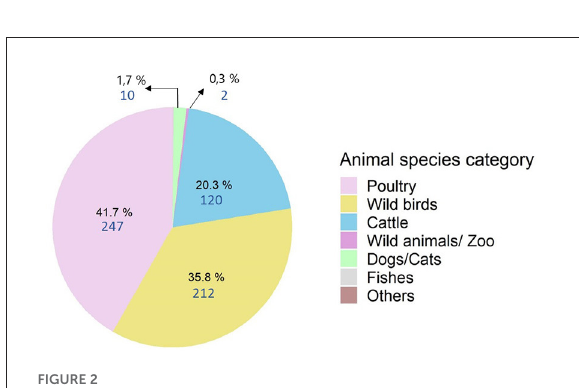
FIGURE2 Distribution of animal botulism outbreaks from 2009 to 2019 by species ( n = 592).